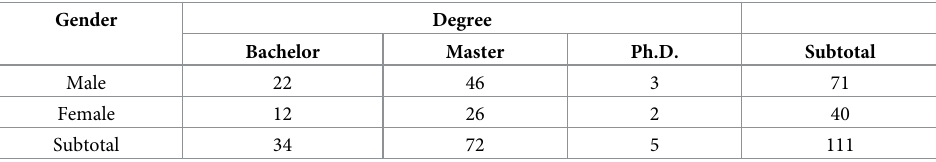
Table 3. Participants’ distribution based on gender and